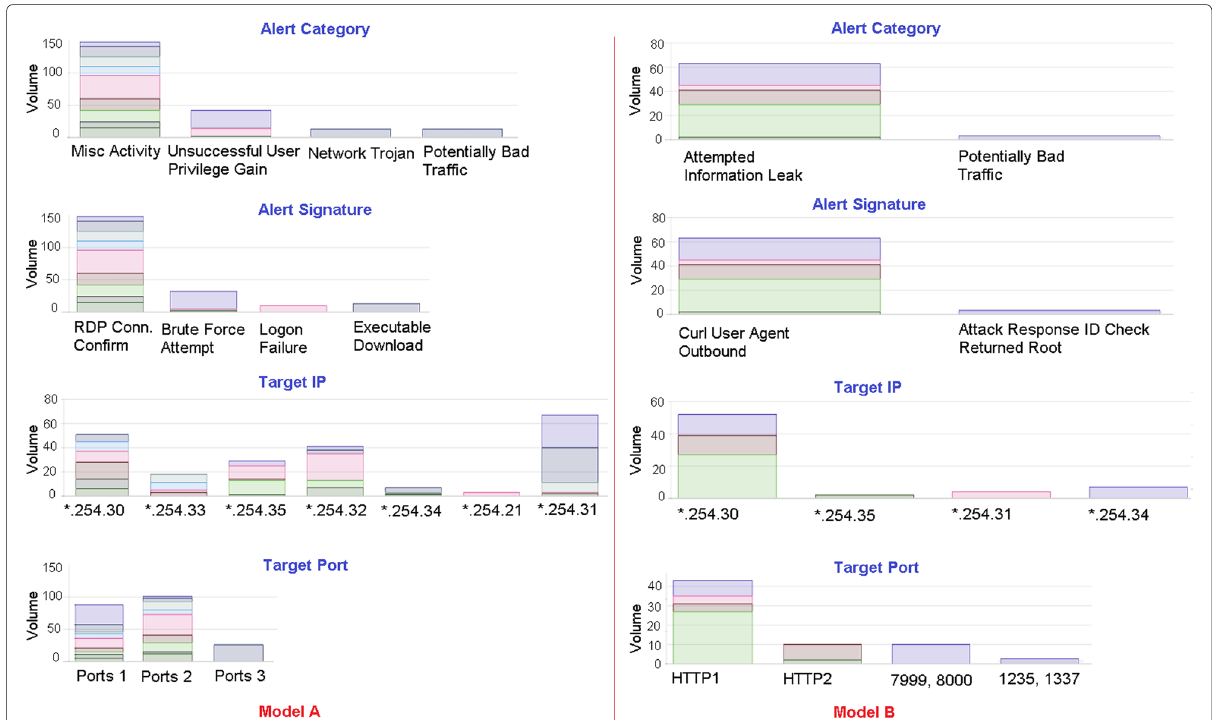
Fig. 12 Alert category, alert signature, target IP and target port feature histograms for Models A (left) and B (right) generated by ASSERT. The x and y axis of each histogram show the individual feature values or categories and the number (volume) of alerts, respectively. Different colors in each bar represent alerts coming from the different